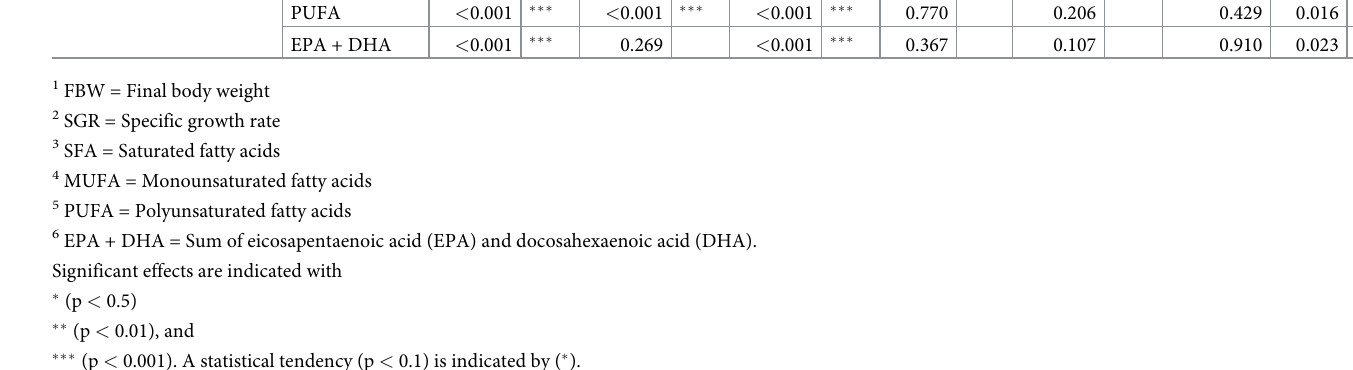
tion of the dietary fish oil level and the holding temperature (Table 4). Generally, feeding the